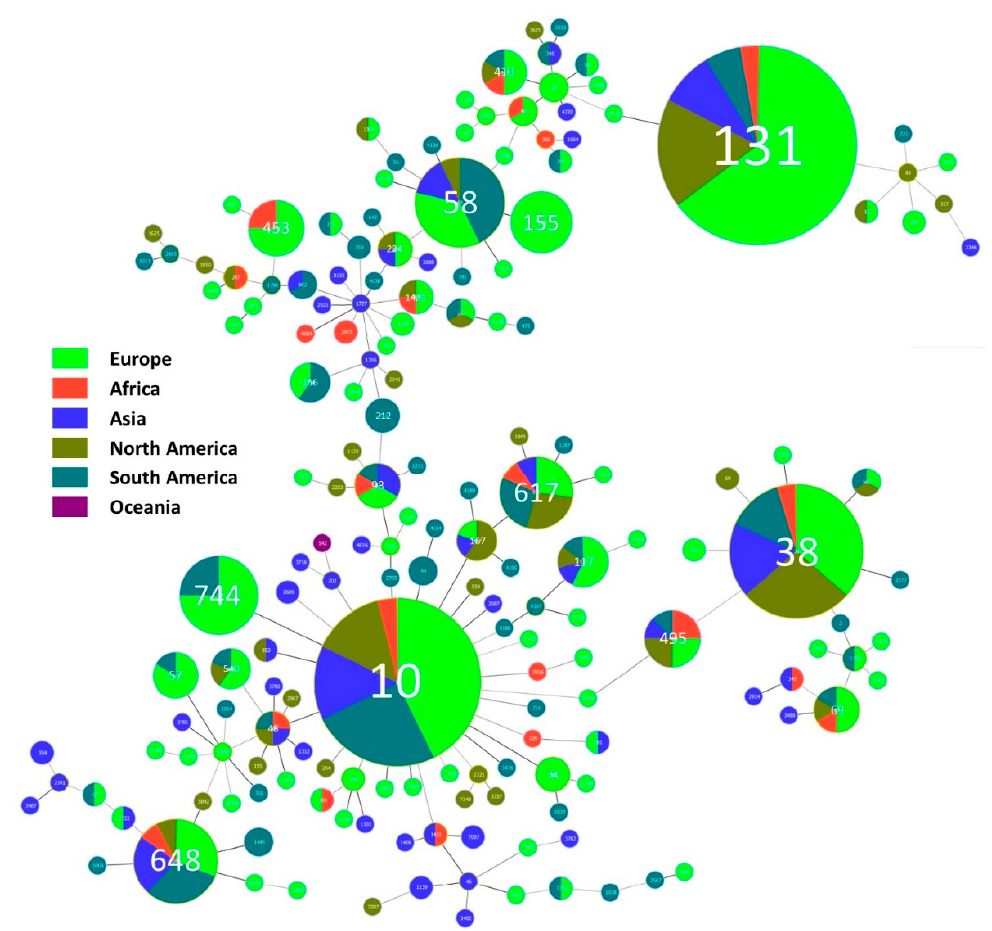
Figure 9. MLST-based minimal spanning tree of 423 ESBL- and AmpC-producing E. coli in wild animals from Europe, Africa, Asia, North America, South America, and Oceania. Node sizes reflect the number of isolates with specific MLST profile. Numbers within the nodes indicate the ST. Node colours refer to the continent origin of isolates with each specific ST. Nodes differing by one, two, or three loci are linked by dark lines. MLST, multilocus sequence typing, ST, sequence type.